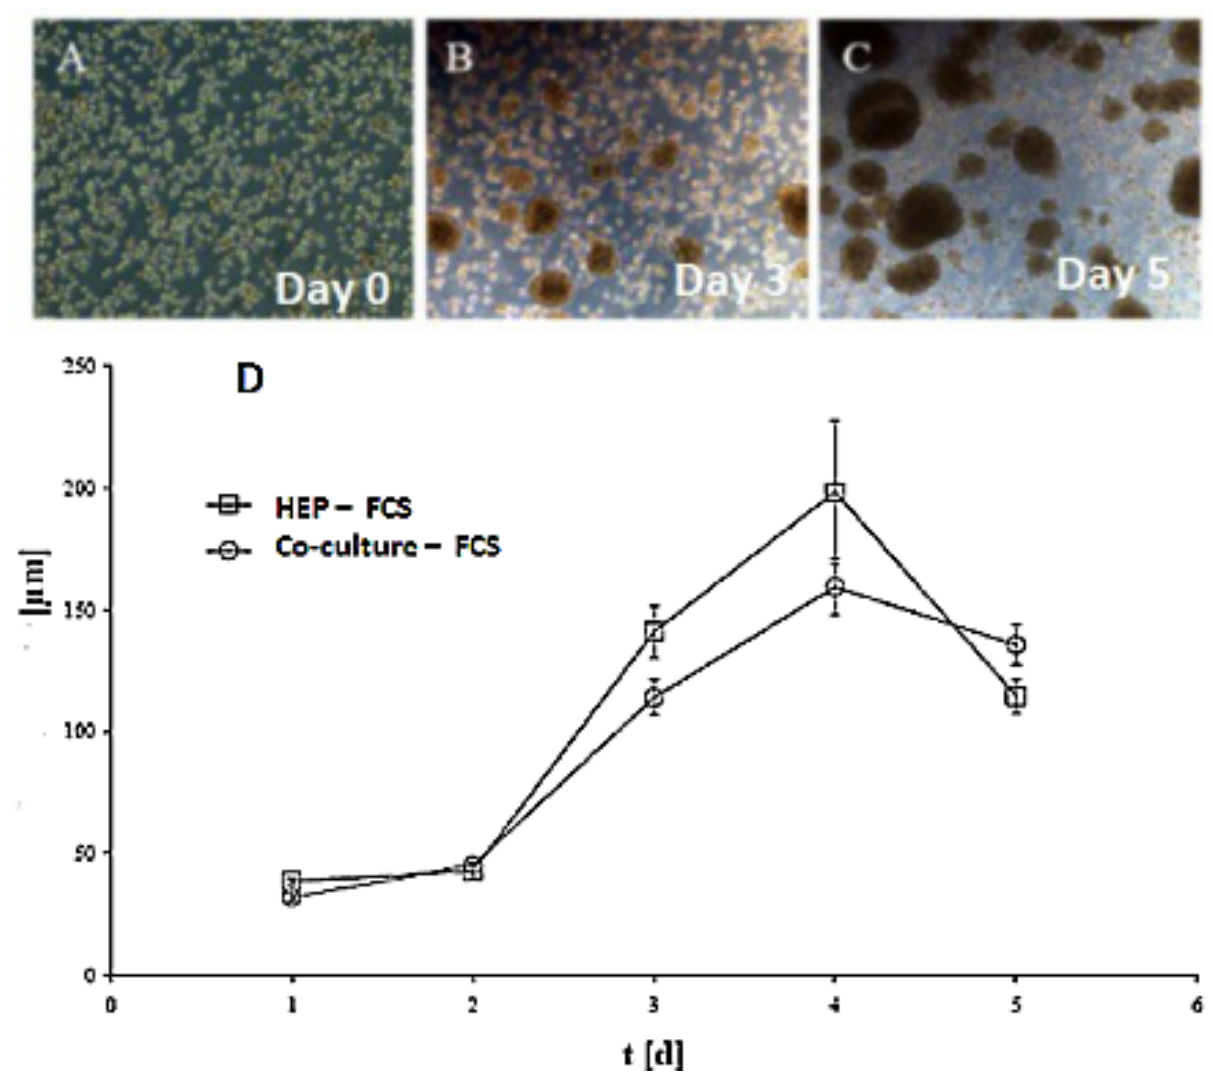
Figure 2. Spheroid formation in serum free culture. Spheroid in serum-free co-culture on day 0 (A); day 3 (B) and day 5 (C); (Magnification: 100×). Scale bar is 100 μ m. Average diameter of the spheroids in the period of five days in a culture serum-free culture of spheroid. (D) Monoculture from serum-free hepatocytes and a co-culture of hepatocytes (Hep) and